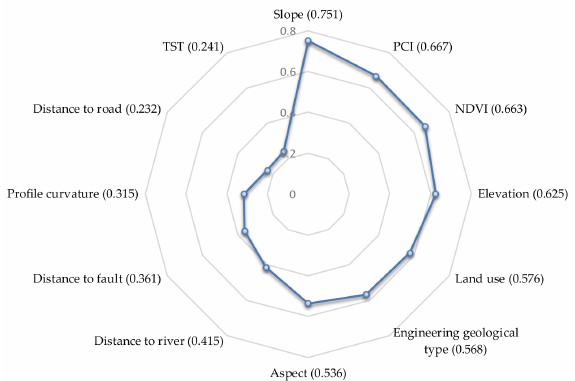
Figure 8. The significance of each of the fourteen factors with respect to